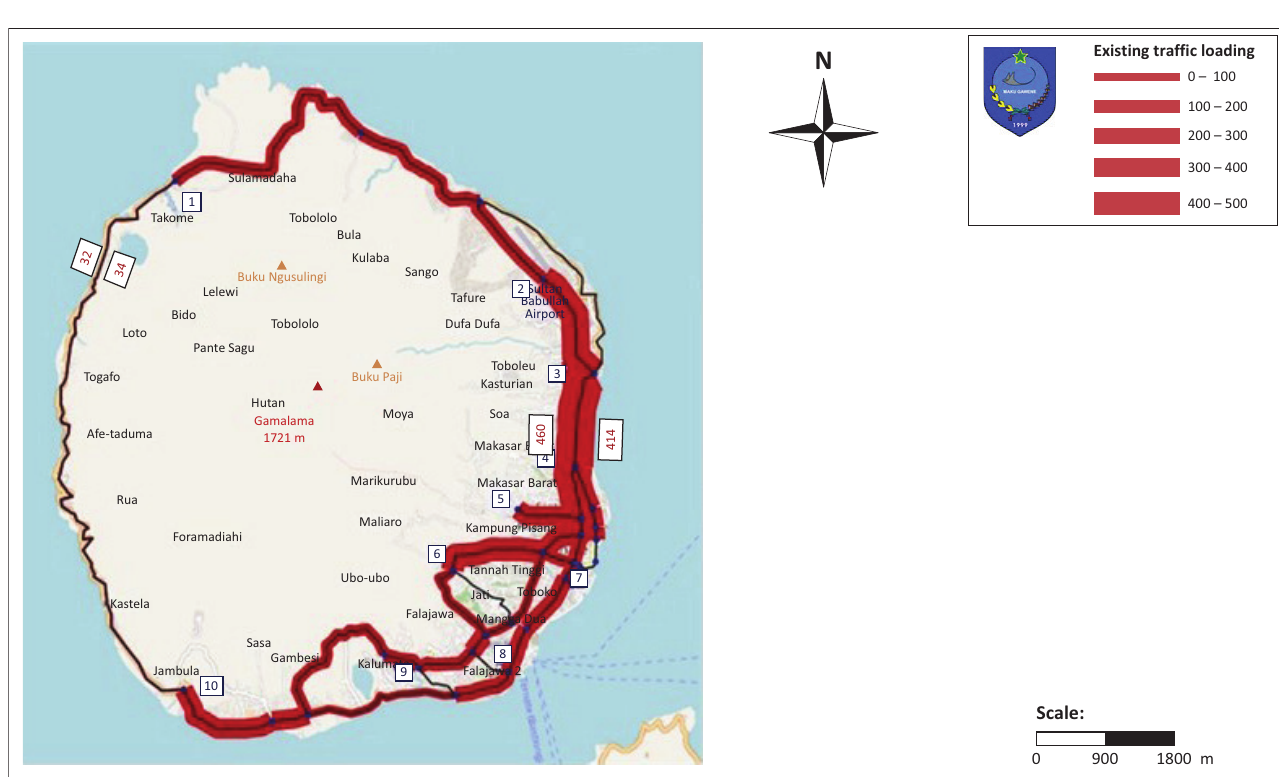
FIGURE 4 : Analysis results on existing traffic